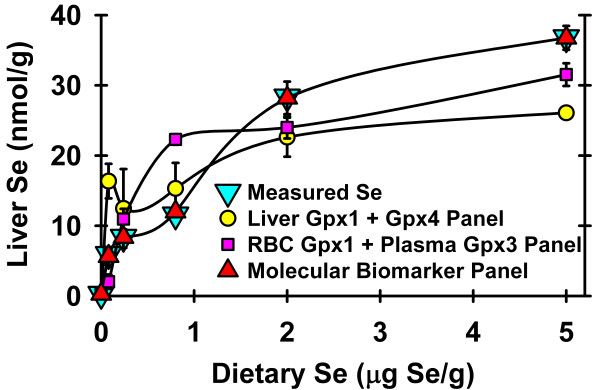
Prediction of liver Se by biomarker panels. Liver Se concentration activity as determined by actual measurement or calculated using biomarker panels based on liver Gpx1 plus liver Gpx4 activities, based on RBC Gpx1 plus plasma Gpx3 activities, or based on the 11-transcript molecular biomarker panel identified by multiple regression analysis, as described in the text. Values are means ± SEM.